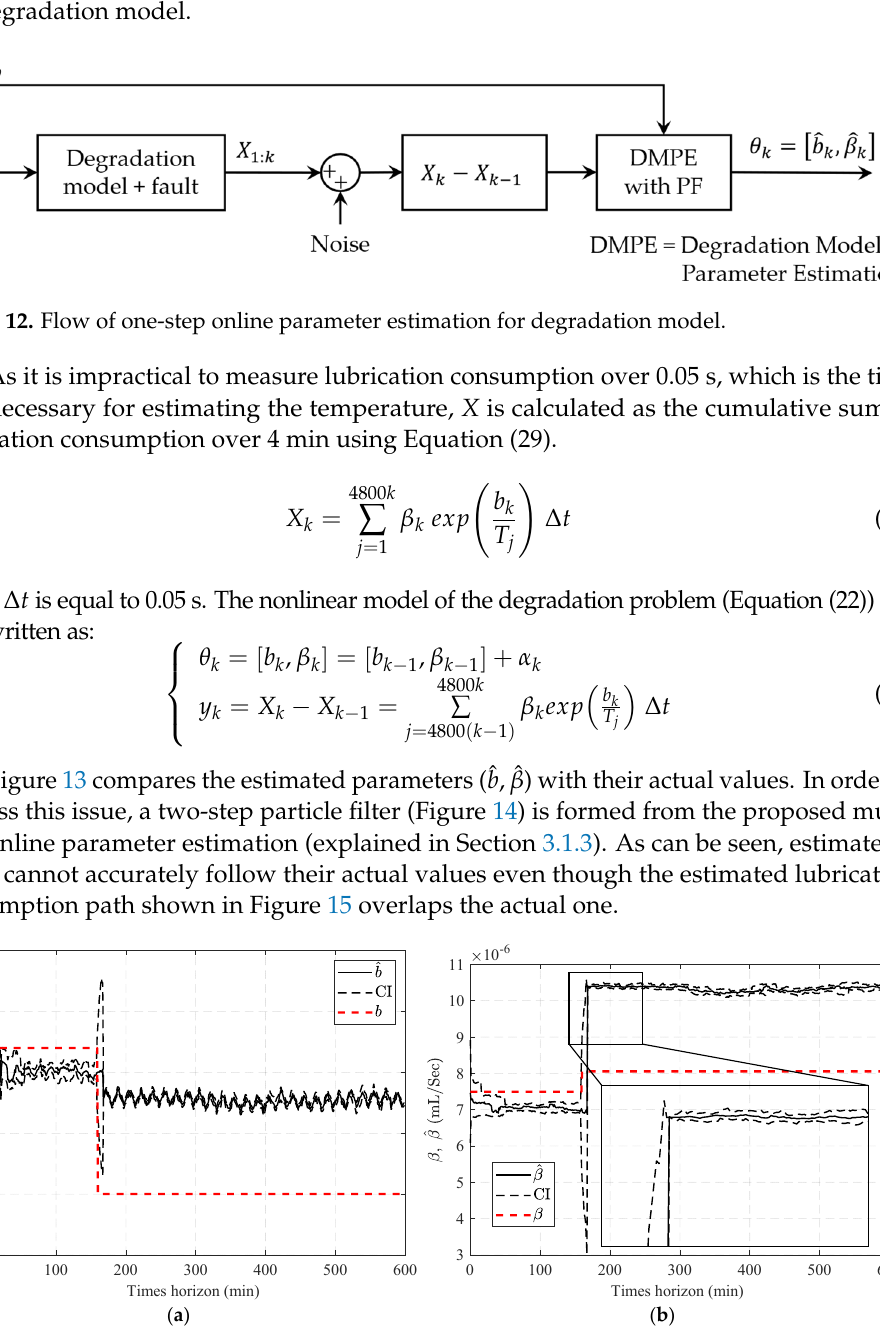
Figure 11. Result of the estimated 𝑇 (cid:3039)(cid:3048)(cid:3029) , using APF: ( a ) low noise scenario and ( b ) high noise sce- nario.